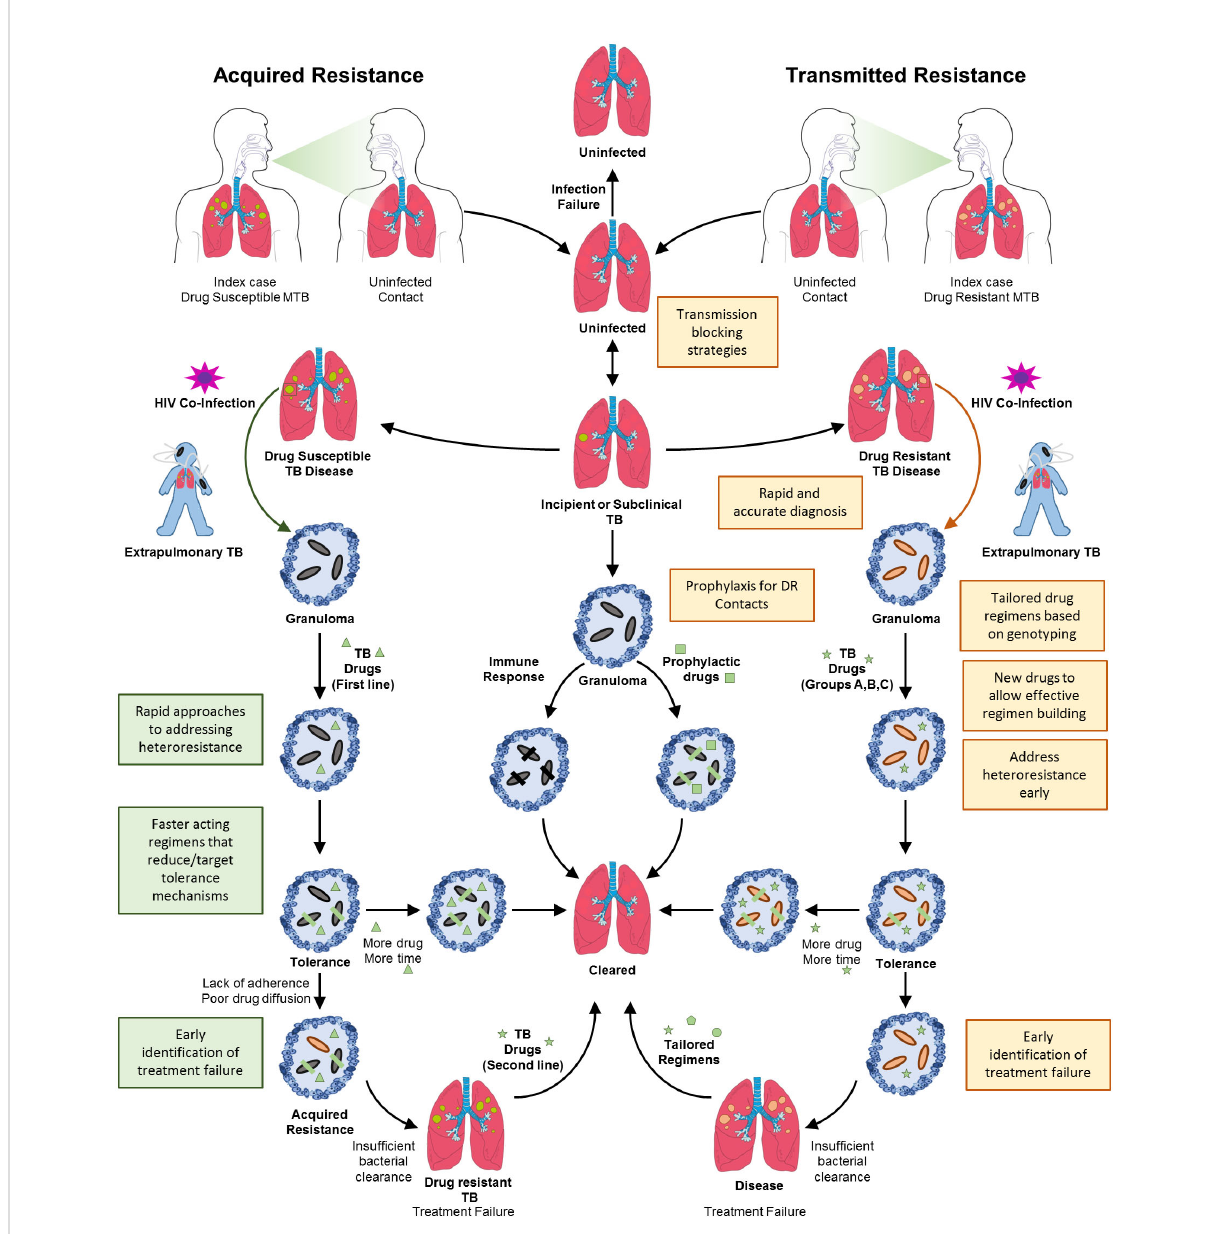
FIGURE 2 Transmitted and acquired drug resistant TB. Drug resistant TB can arise by two mechanisms, acquired resistance or directly through transmitted resistance. Shown is the natural progression of TB infection and disease, initiated by transmission of bacteria, followed by the development of incipient or subclinical TB. If identi fi ed, incipient or subclinical TB can be resolved by administration of prophylaxis or spontaneously. A small proportion of these cases will progress to full blown TB disease in the lungs wherein granulomas necrotize and rupture. Concomitant HIV infection will also result in extrapulmonary TB. In the case of infection with drug sensitive TB, the bacterial population will expand and drug treatment will result in the survival of tolerant organisms that will eventually be cleared with protracted treatment. The phenomenon of drug tolerance highlights the need for additional and faster acting drug treatments. Lack of adherence or poor drug diffusion will result in these tolerant organisms eventually acquiring stable drug resistance, resulting in treatment failure and drug resistant TB. This will necessitate administration of an alternate regimen directed at eliminating resistant organisms. Transmitted resistance occurs when an individual is infected with organisms that are genetically drug resistant. In the absence of diagnostic testing capable of identifying drug resistance mutations for most drugs except rifampicin, the treatment of these patients with fi rst-line drugs will unfortunately result in failure. If identi fi ed, together with appropriate susceptibility testing, treatment of drug resistant TB follows a similar sequence of events to that for drug susceptible TB. Given the longer durations of treatment, the chances for evolution of further resistance are high. Hence, the requirement for the correct choice of regimens and development of novel drugs to eliminate these resistant organisms. Shaded boxes indicate the need for new interventions or health system